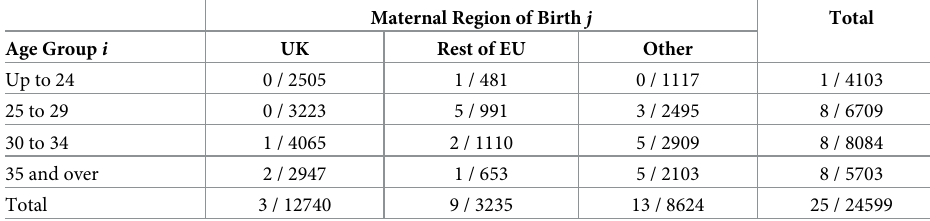
all regions of England apart from London were to UK-born women, while in London the pro- portion of births to UK-born women was lower and similar to women born outside of the EU.